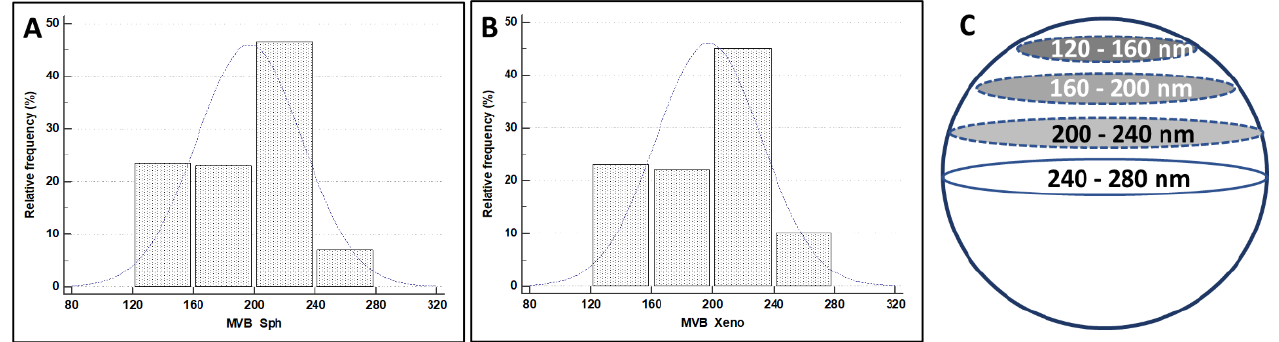
Figure 13. Histograms illustrate the distribution of MVB diameter values in MTSs and xenografts. ( A ) MVB diameter in spheroid secretion. ( B ) MVB diameter in xenograft secretion. ( C ) The maxi- mum diameter value is the less frequent, and the others occur at least two times (over and above the equator).